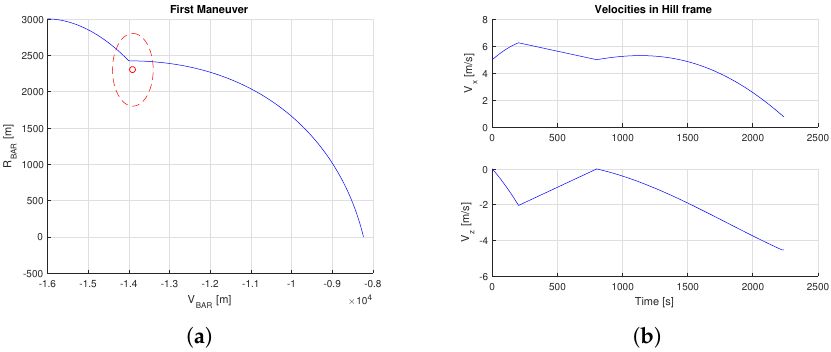
Figure 6. First maneuver highlights for the LQR (Linear Quadratic Regulator) controller. ( a ) First Maneuver: V BAR − R BAR plane. The red circle represents the obstacle (dotted line = safety radius, red circle = obstacle center). ( b ) Relative